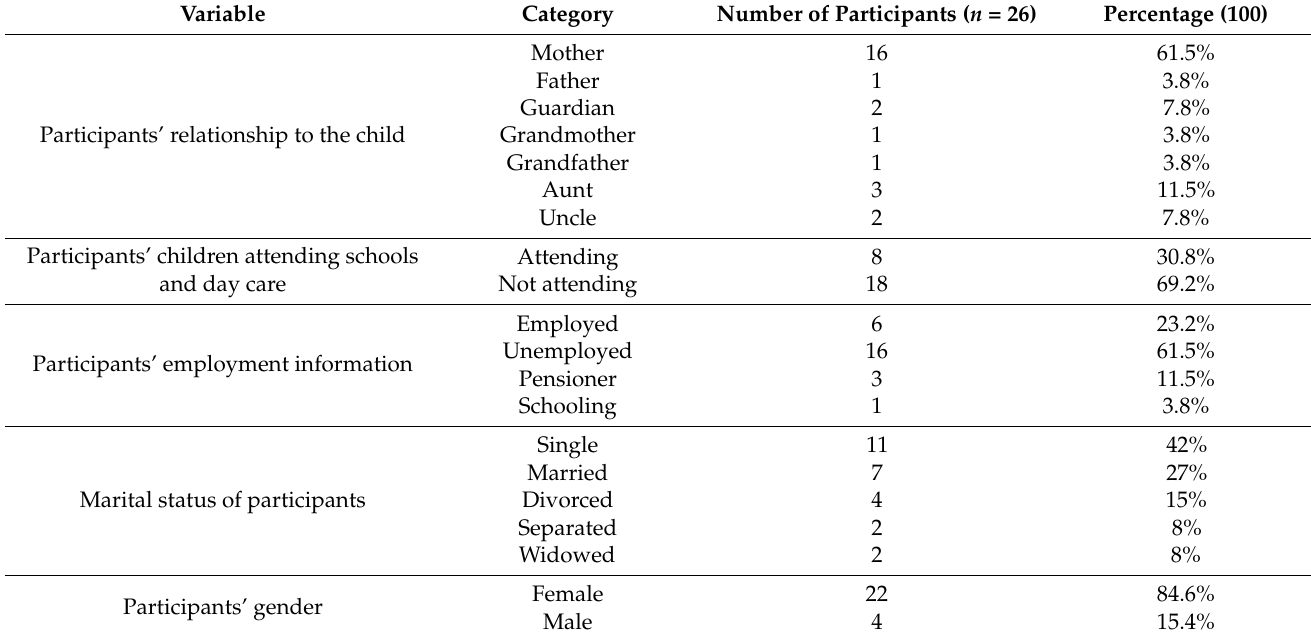
Table 1. Socio-demographic data of families and the children with